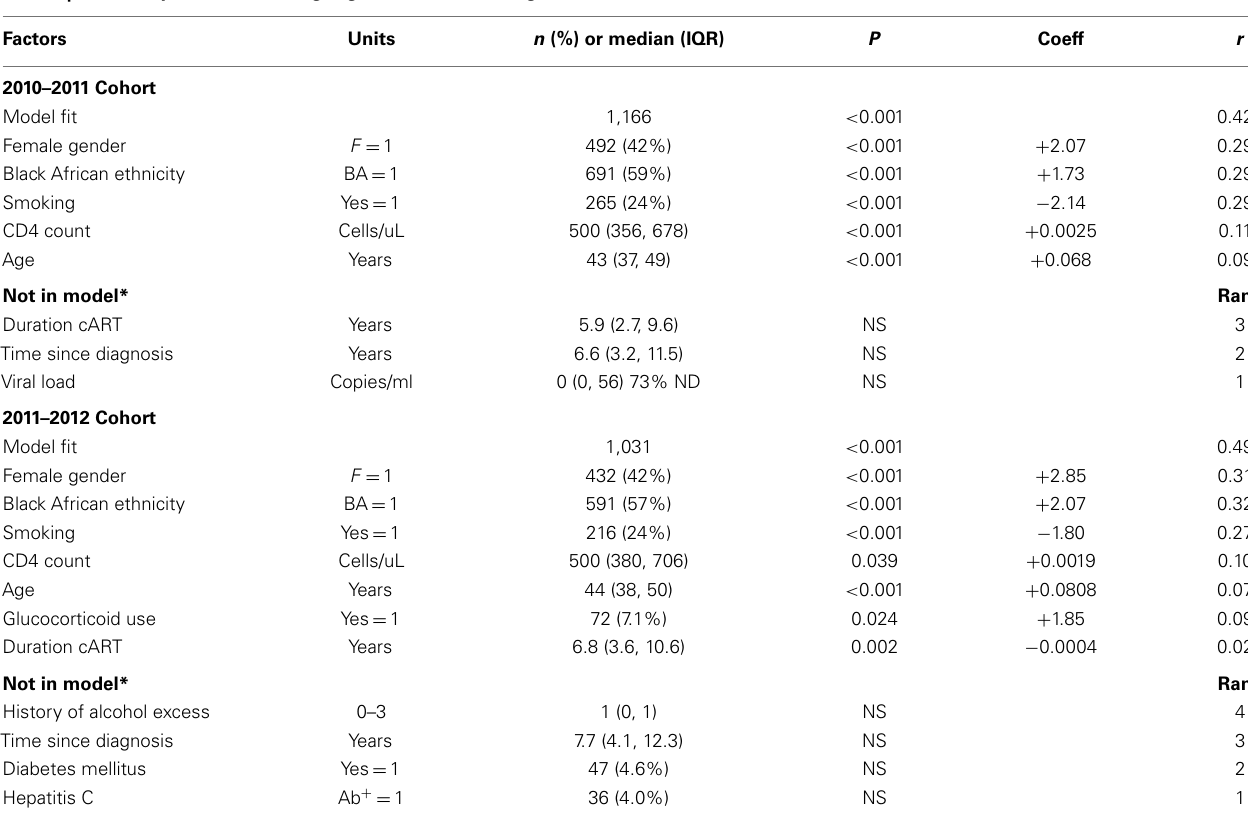
Table 3 | Potential predictors or weight gain; correlates of high BMI